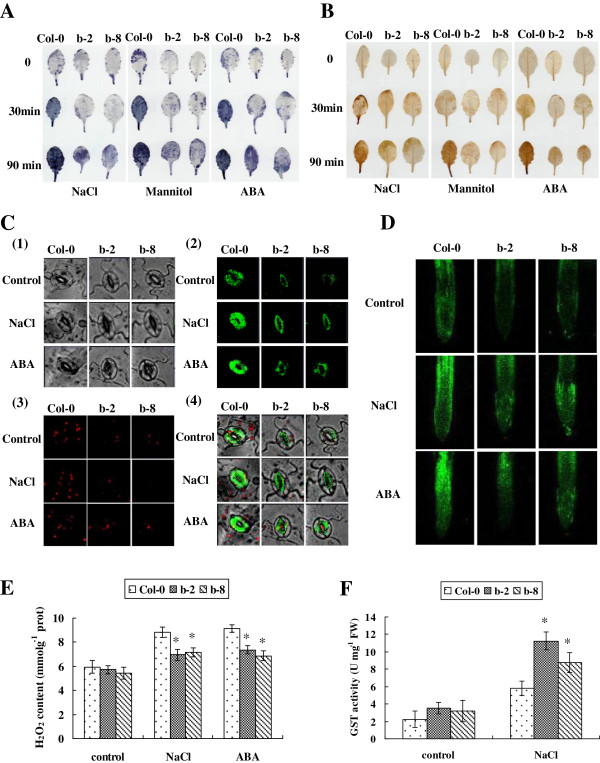
The constitutive expression of ThbZIP1 decreases ROS levels and enhanced GST activity. A, B: The leaves from Col-0 and transgenic plants were pretreated with NaCl, mannitol, or ABA, and were stained with NBT to visualize O2-(A), or were stained with DAB to visualize H2O2(B). C: Analyses of ROS production in intact guard cells of transgenic and Col-0 plants indicated by H2DCF-DA. Epidermal peels were loaded with H2DCF-DA after the incubation with 10 μM ABA or 150 mM NaCl for 2 h. (1) peel cells imaged under bright field; (2) ROS in guard cells were detected by H2DCF-DA (ROS shown as green fluorescence); (3) Chloroplast in the leaves that shown as red fluorescence; (4) merge of bright field and fluorescence (chloroplast shown as red fluorescence). D: Detection of ROS accumulation in root tips of transgenic and Col-0 plants using H2DCF-DA staining method. E: Measurement of H2O2 level in transgenic and Col-0 plants. F: Comparison of GST activity between Col-0 and ThbZIP1-transformed plants. All experiments were repeated three times. Data are means ± SD from three independent experiments. * Significant (t test, P < 0.05) difference compared with Col-0 plants.